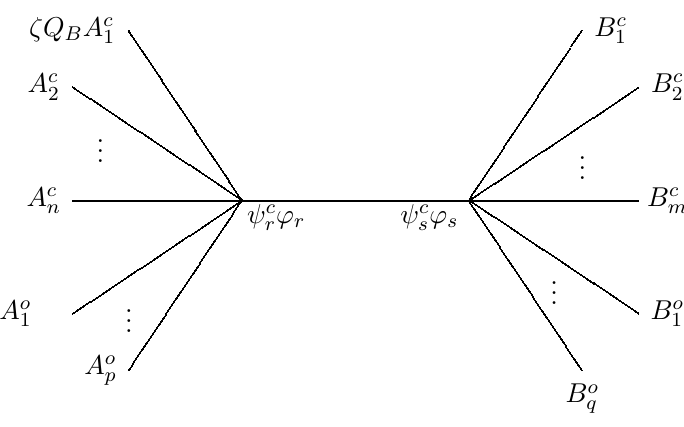
Figure 1 . A Feynman diagram where a 1PI vertex with the external states (cid:16)Q B A c A c ; A o (cid:1) (cid:1) (cid:1) A o and an internal closed string state and another 1PI vertex with the external states n p 1 B c ; (cid:1) (cid:1) (cid:1) ; B c ; B o ; (cid:1) (cid:1) (cid:1) B o and an internal closed string state are joined by a closed string m q 1 1